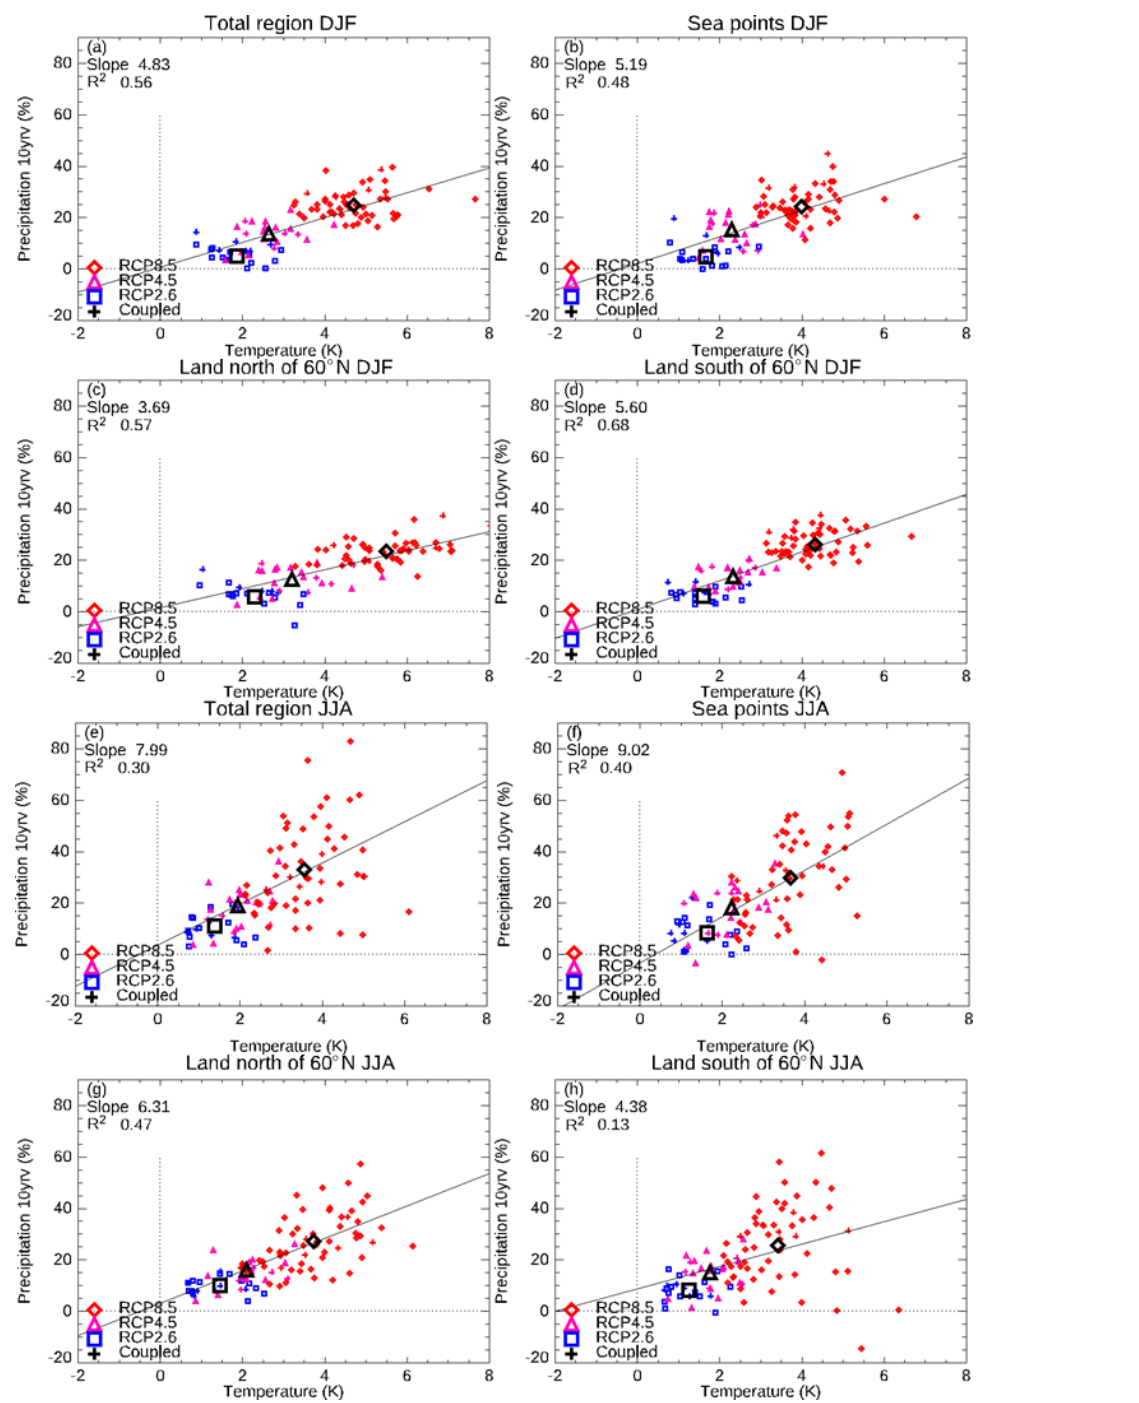
Figure 4. Relative change 1981–2010 to 2071–2100 of the 10-year return value of daily precipitation against temperature change for indi- vidual models and all scenarios. Scenario means are indicated by larger black symbols. Blue squares: RCP2.6; pink triangles: RCP4.5; red diamonds: RCP8.5; green crosses: the ENSEMBLES simulations analysed in BACC II (2015). Plus signs in colours corresponding to the scenario: the RCA4-NEMO atmosphere–ocean coupled simulations. Calculation performed for subsets of the Baltic catchment: the entire catchment; sea points; land points north and south of 60 ◦ N, respectively. Panels (a) – (d) show winter; panels (e) – (h) show summer. The lines, with quoted slope and squared correlation coefficient, are best fits to all EURO-CORDEX and ENSEMBLES data but do not include coupled-model